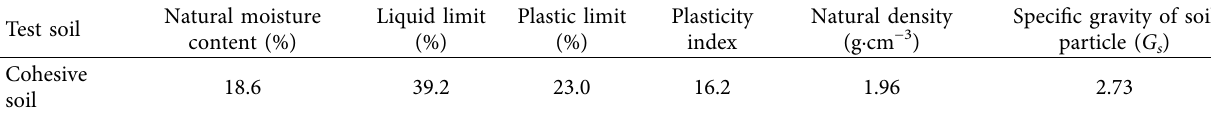
Table 1: Physical properties of soil.